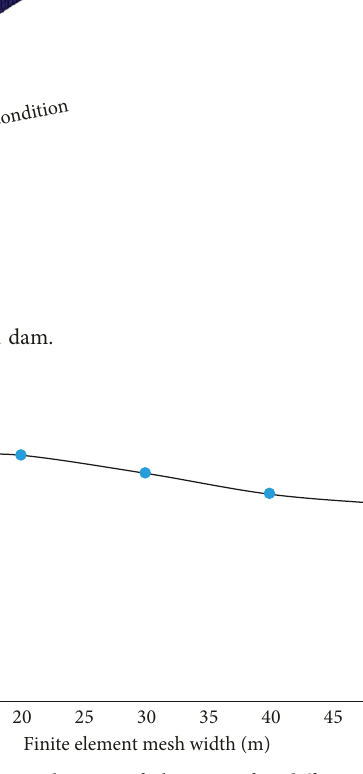
Figure 11: Settlement changes of the crest for different mesh